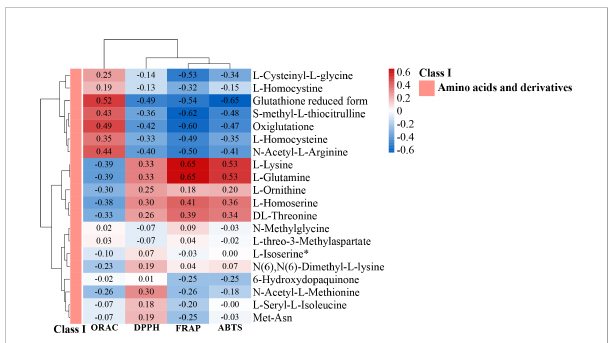
FIGURE 13 Heat map of the correlation between amino acids and their derivatives in core metabolites and antioxidants. Different letters above columns and the color of the column indicate the correlation, with the larger and the redder the color and the greater the correlation coef fi cient.